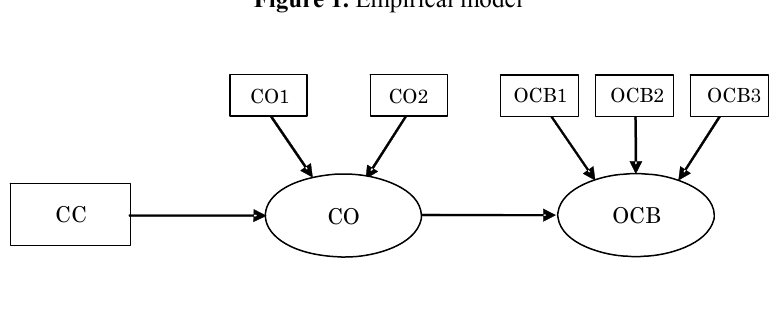
Figure 1. Empirical model